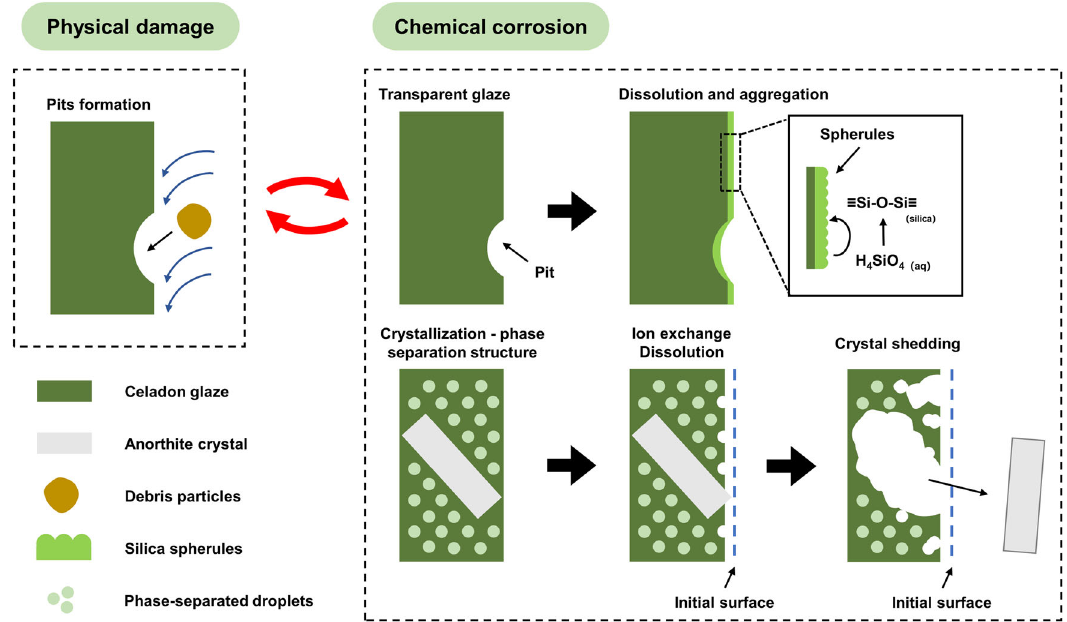
Fig. 4 Schematic of the degradation process of celadon glazes in the marine environment. The red two-way curved arrows indicate the synergistic effects of physical damage and chemical corrosion. The description of each elements is shown in the lower left corner of the fi